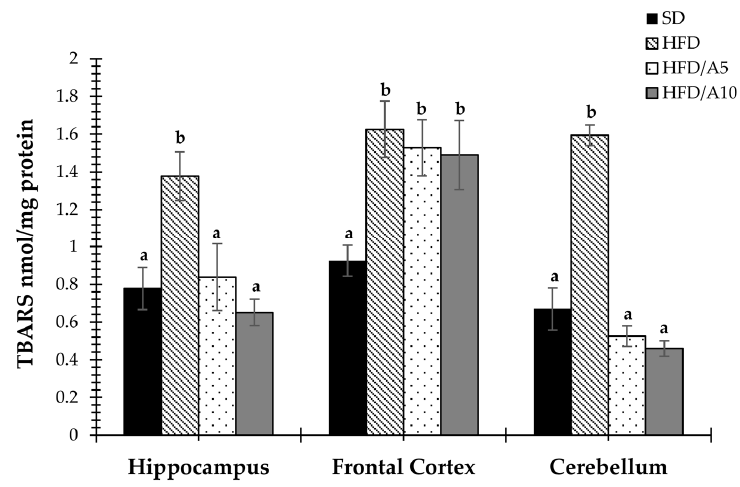
Figure 5. Effects of fructans on TBARS levels in the hippocampus, frontal cortex and cerebellum of mice fed with standard diet (SD); high-fat diet (HFD); high-fat diet with agave fructans 5% (HFD/A5); high-fat diet with agave fructans 10% (HFD/A10). One-way ANOVA and Tukey contrasts were performed to compare differences among groups. The data are represented as the mean with their standard errors of the mean (SEM). N = 10. Mean values with unlike letters (a,b) were significantly different ( p < 0.05).